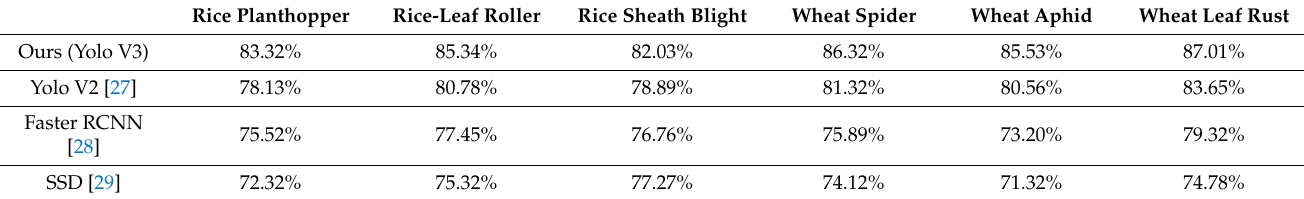
Table 4. Average precision (AP) of different methods on different diseases and pests.